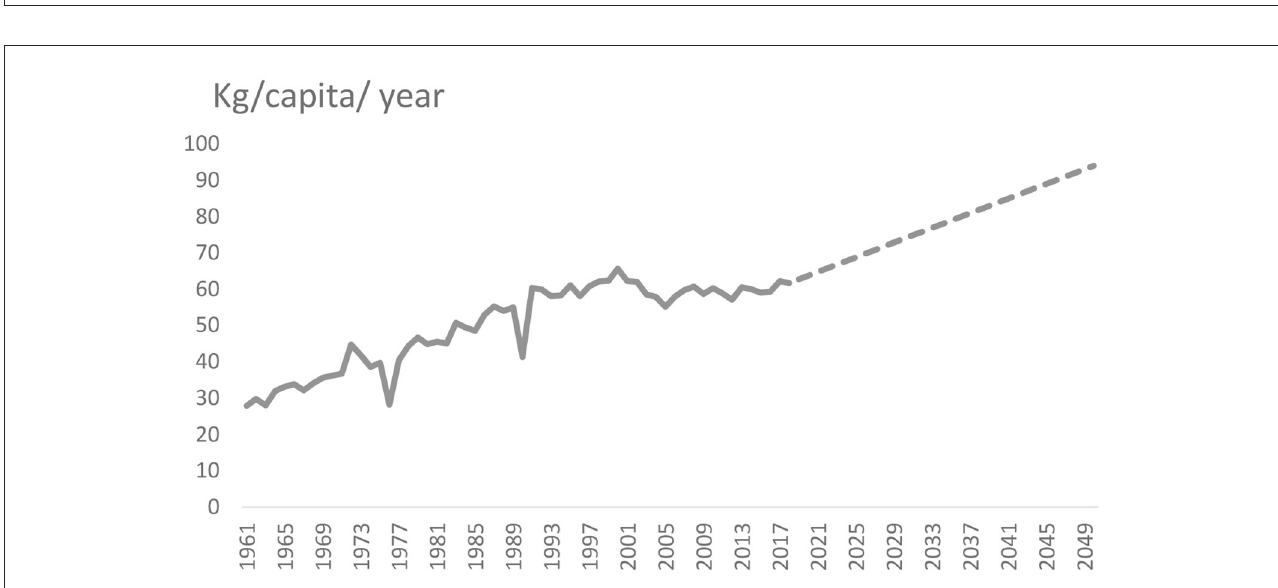
FIGURE4 Actual and predicted yearly per capita wheat consumption in KG in India, during 1961–2050 [ln(yearly/capita/KG)], based on Vector Error Correction (VEC) model estimation procedure. Broken line reflects projected consumption. Source: Authors’